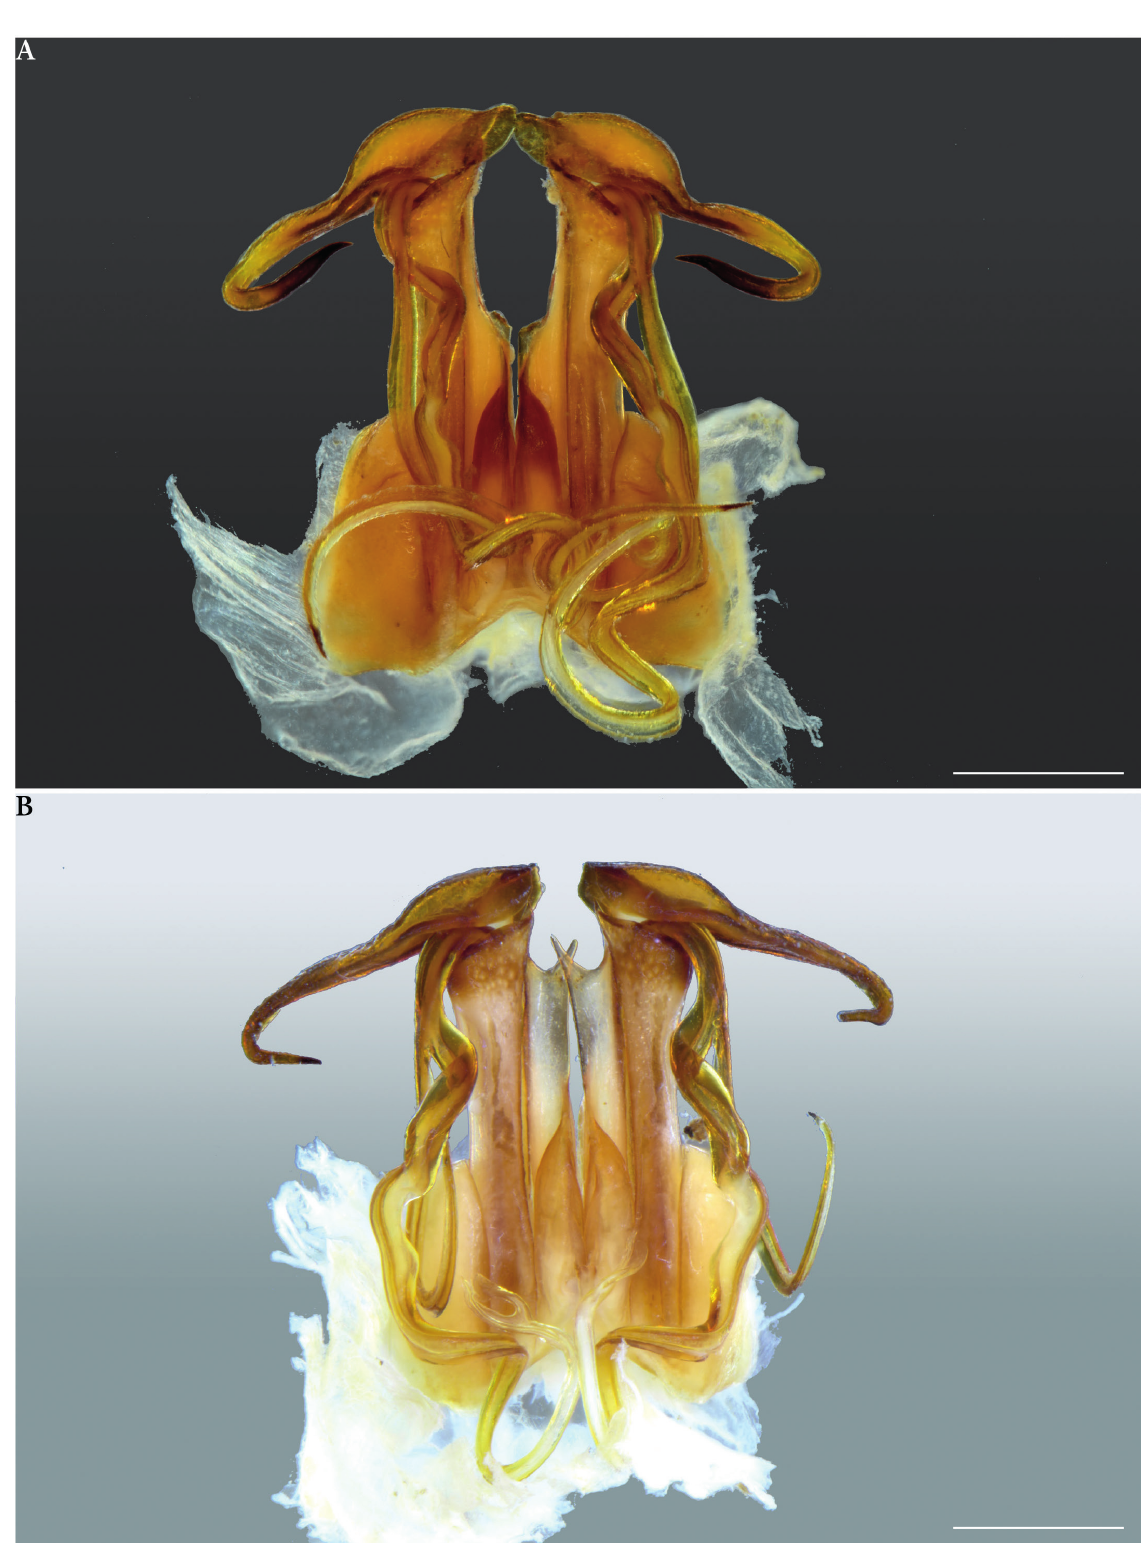
Fig. 5. Attemsostreptus reflexus , males without locality data. A . ♂, (NHMD621669). B . ♂, deviating gonopods (HNHM diplo-1697). Scale bar: 1